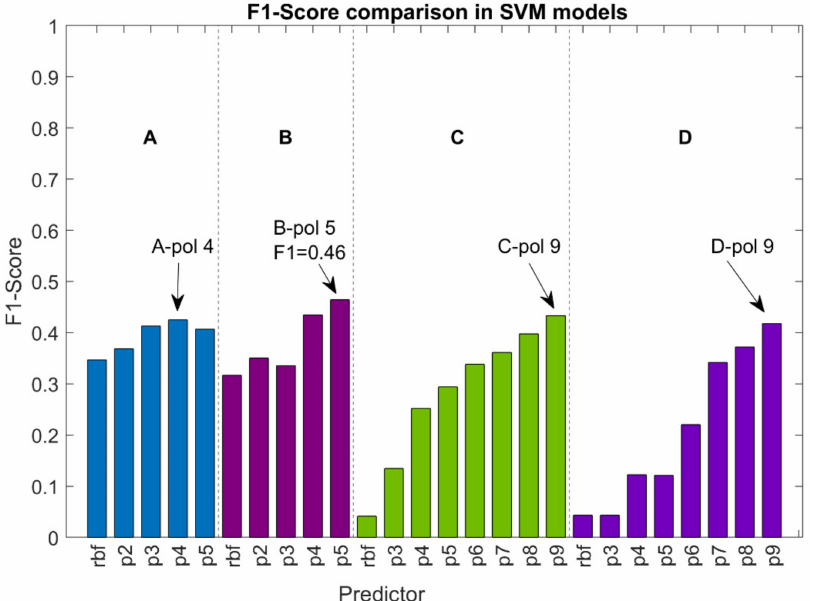
Figure 3. Comparison of support vector machines (SVM) models using the F1-score statistic. A, B, C, D: combination of features; rbf: Gaussian radial basis kernel; p2–p9: polynomial kernel of degree from 2 to 9.